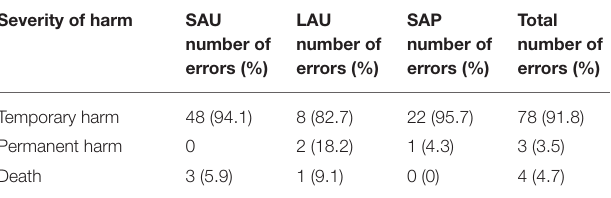
TABLE 5 | Distribution of severity of patient harm due to adverse incidents at each hospital (see Figure 1 for hospital abbreviations). Severity of harm